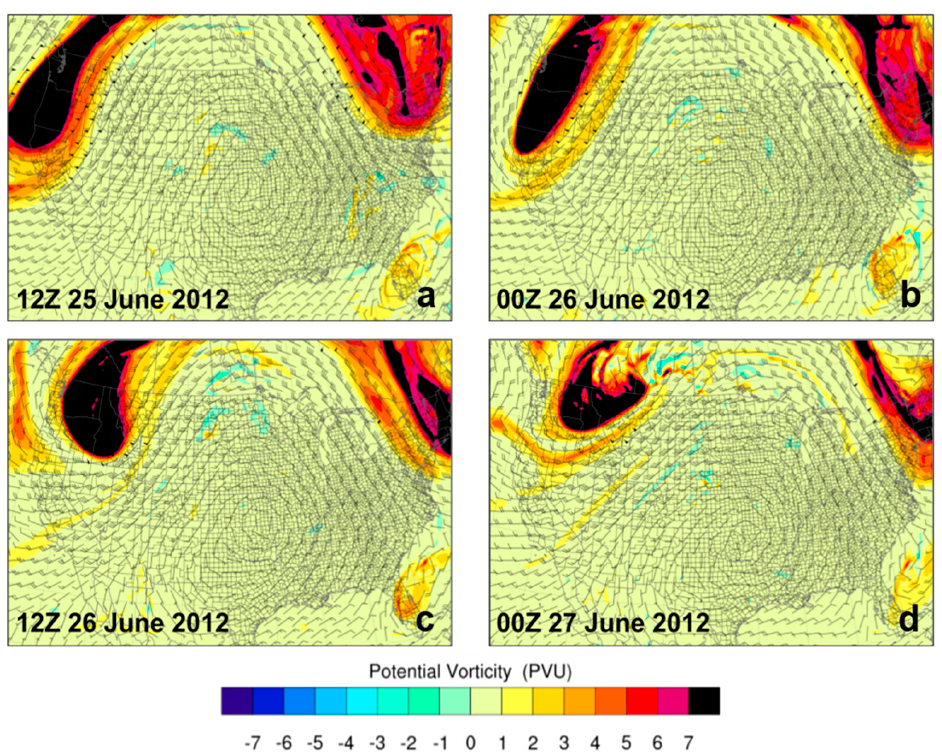
Figure 14. WRF-ARW 18 km simulated 330 K potential vorticity (fill in PVU (10 − 6 KhPa − 1 s − 1 ) and wind barbs (kts) for ( a ) 12Z 25 June, ( b ) 00Z 26 June, ( c ) 12Z 26 June, and ( d ) 00Z 27 June 2012. By 27 June 2012, the core of the ridge/mixed layer started to extend north-northeast.